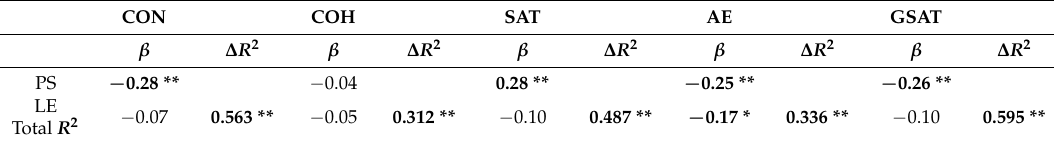
Table 2. Hierarchical regression analysis in which the quality of the partnership and its components were explained variables. CON COH SAT